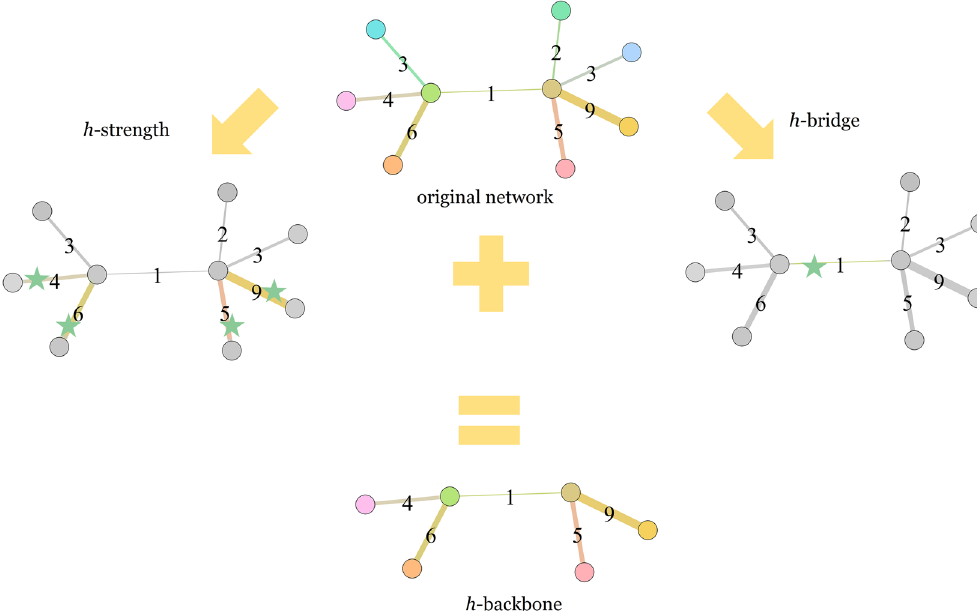
Figure 5. Extracting the h -backbone in a weighted network (The pentagram at the edge indicates that this edge is preserved in the